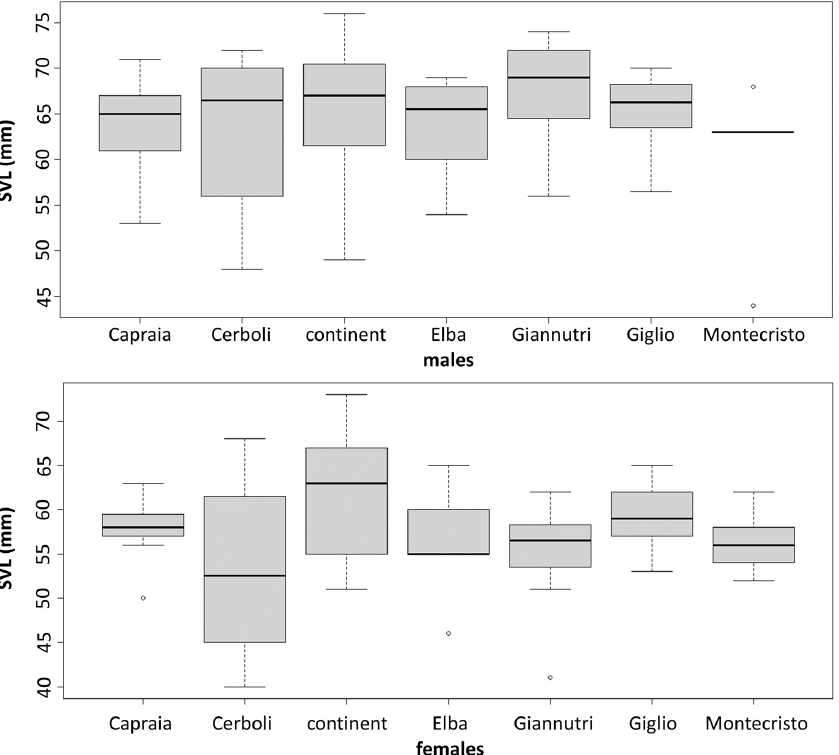
Figure 5. Boxplots for SVL in males and females. There is no significant variation across the sampled localities.